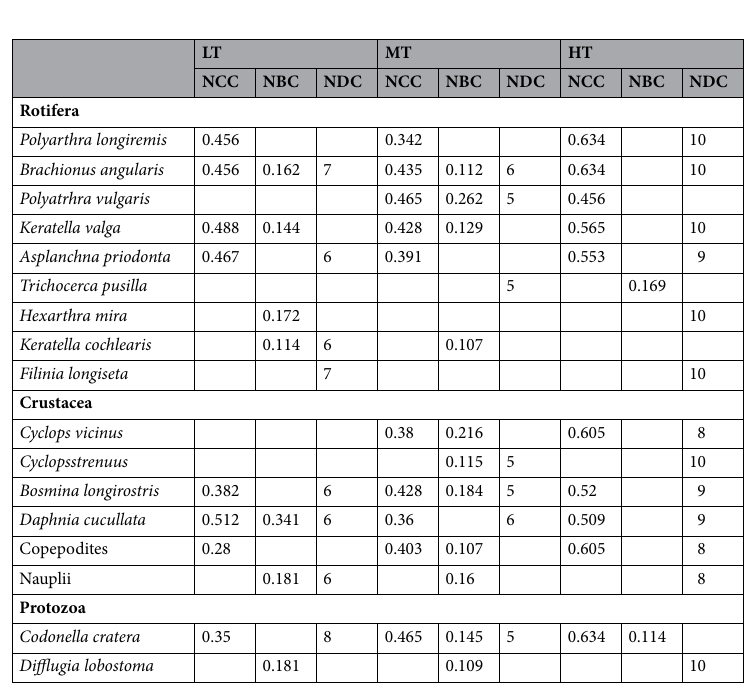
Table 3. Zooplankton species with the highest net attribute. NCC node closeness centrality, NBC node betweenness centrality, NDC node degree centrality.